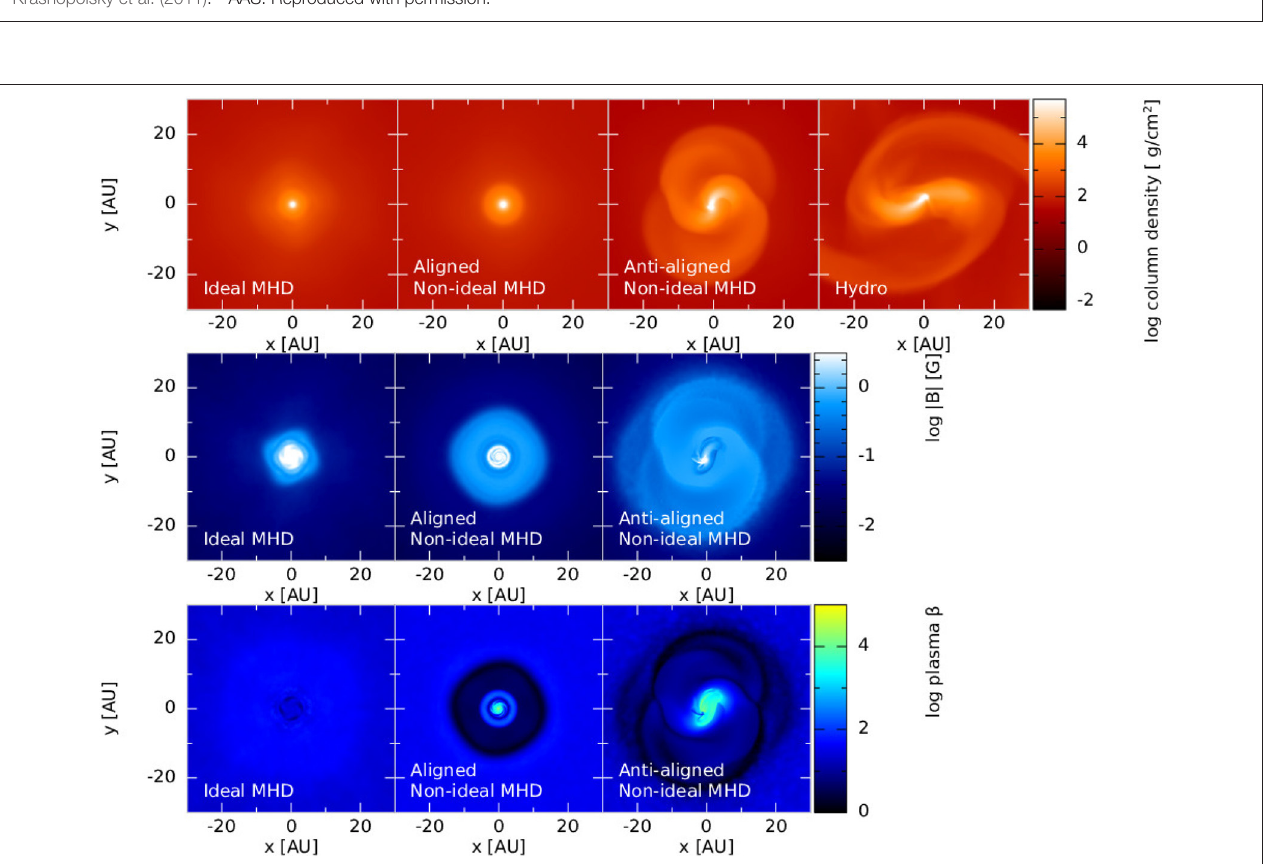
FIGURE 7 | Rotational profiles for aligned, no rotation and anti-aligned two-dimensional models. The initial rotation in the rotating models is v φ = − 2 × 10 4 cm s − 1 . The gas in the outer regions is governed by the initial conditions, while Keplerian discs of r ∼ 10 15 cm form in all three models. These are Figures 1b, 3b, and 2b of Krasnopolsky et al. (2011). © AAS. Reproduced with permission.